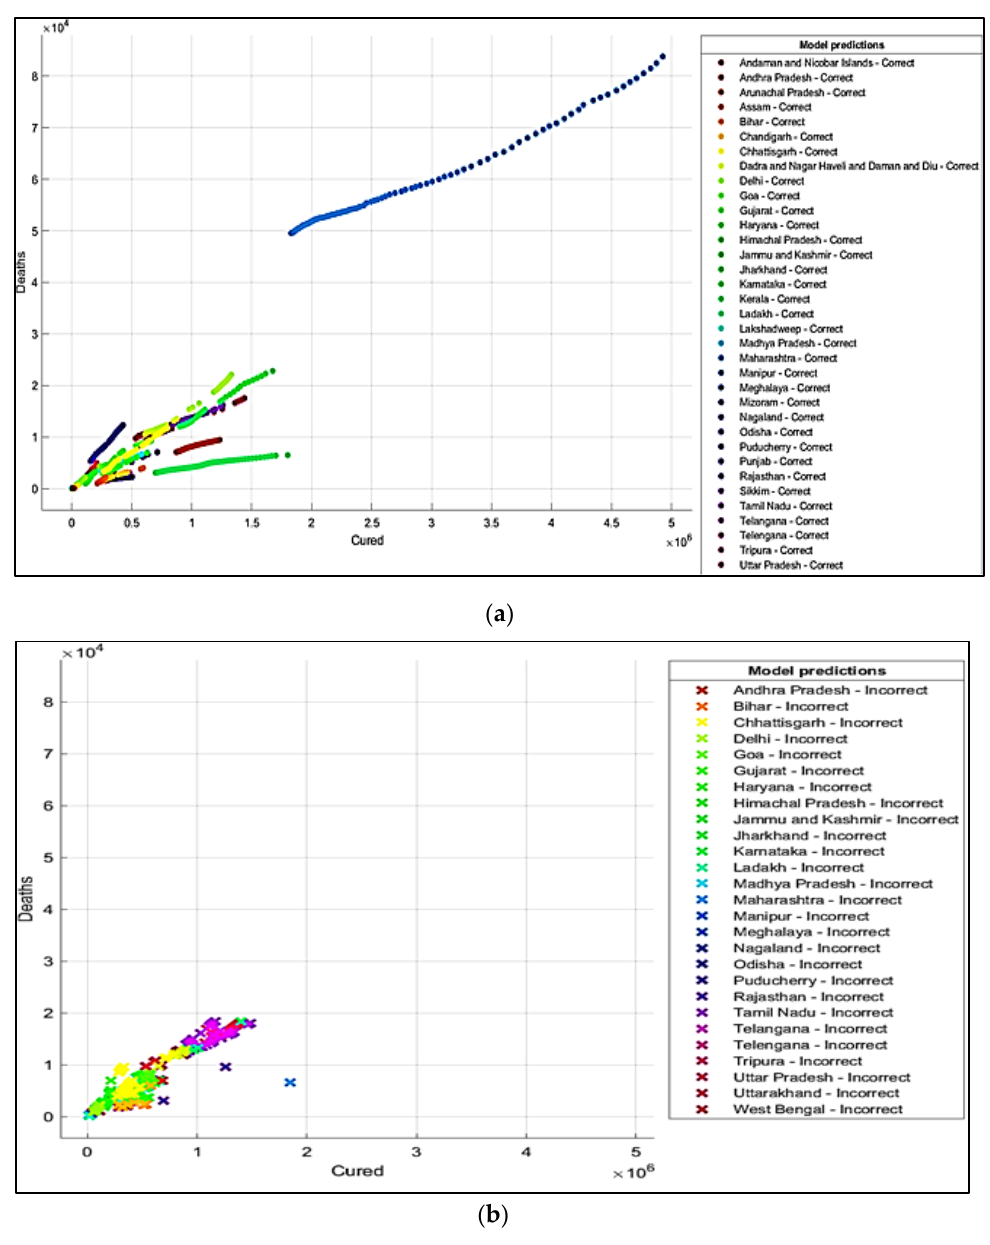
Figure 4. ( a ) Correct Predictions by Decision Tree ‘Cured’ vs. ‘Deaths’. ( b ) Incorrect Prediction by Decision Tree ‘Cured’ vs. ‘Death’.